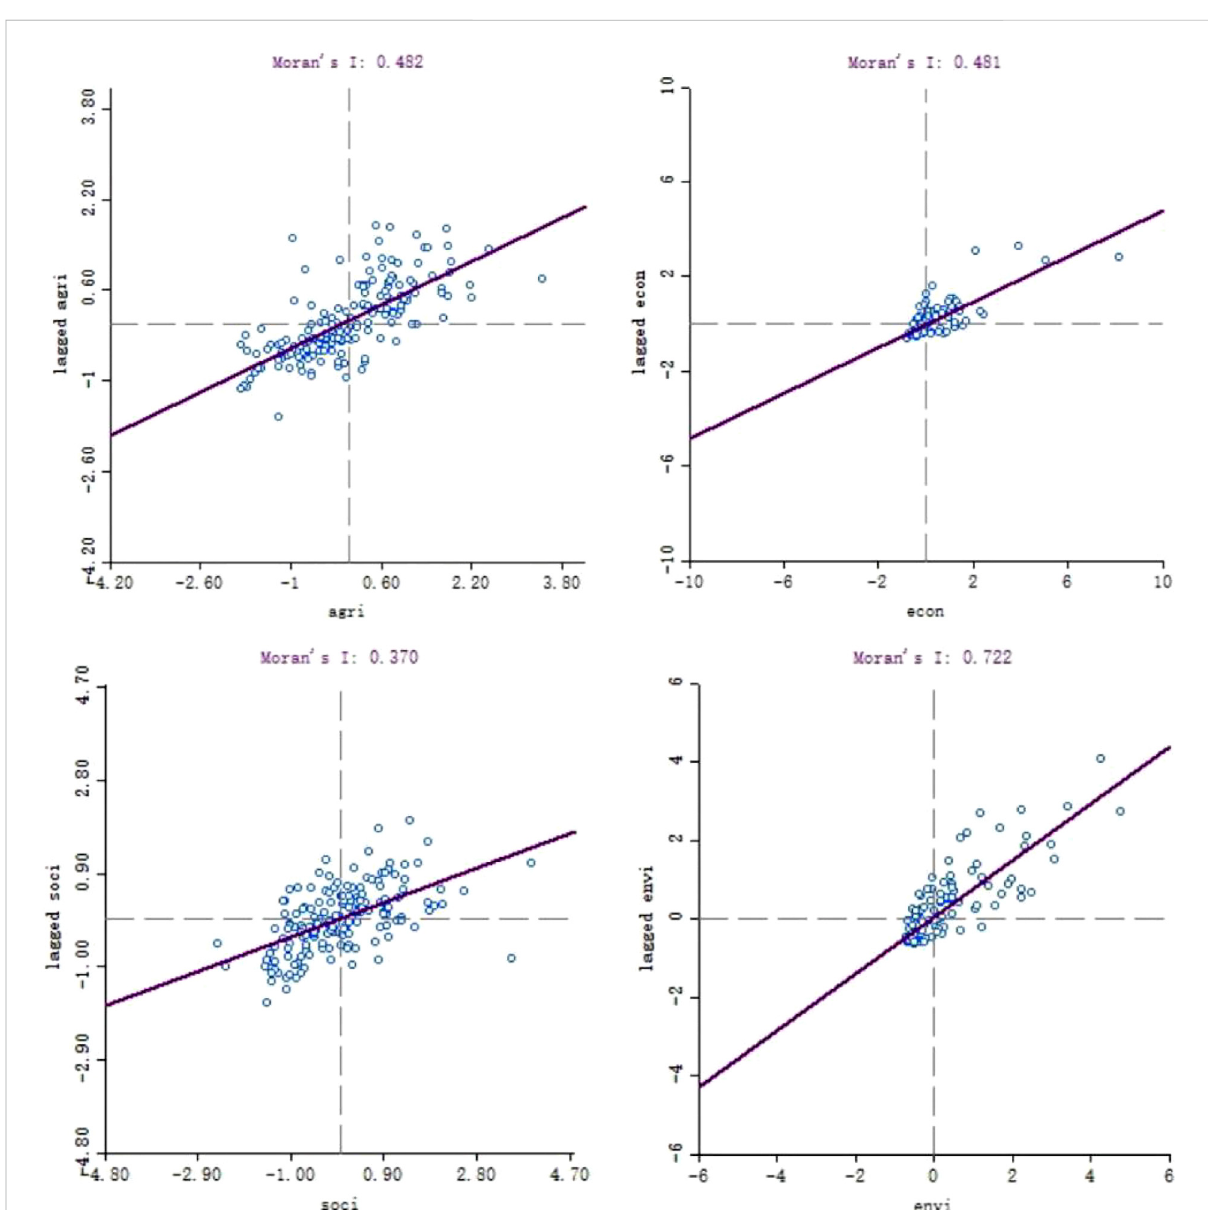
FIGURE 3 Moran ’ s I scatter diagram of rural-area multi-functionality in Hebei